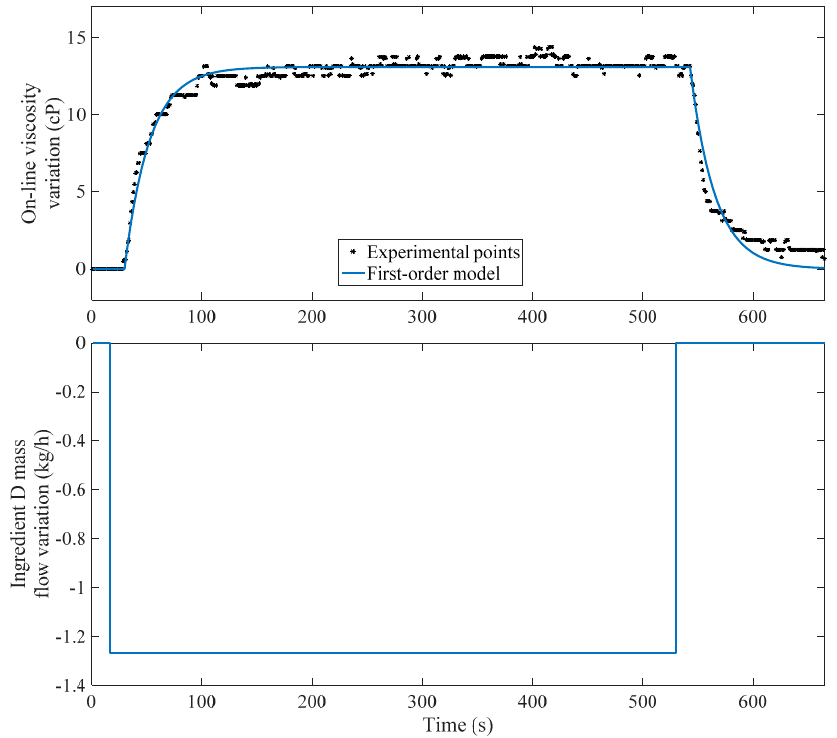
Figure 6. Standardised residuals with respect to predicted viscosities at: 0.1 s − 1 (left upper panel), 1 s − 1 (right upper panel), 10 s − 1 (left lower panel) and 1100 s − 1 (right lower panel).